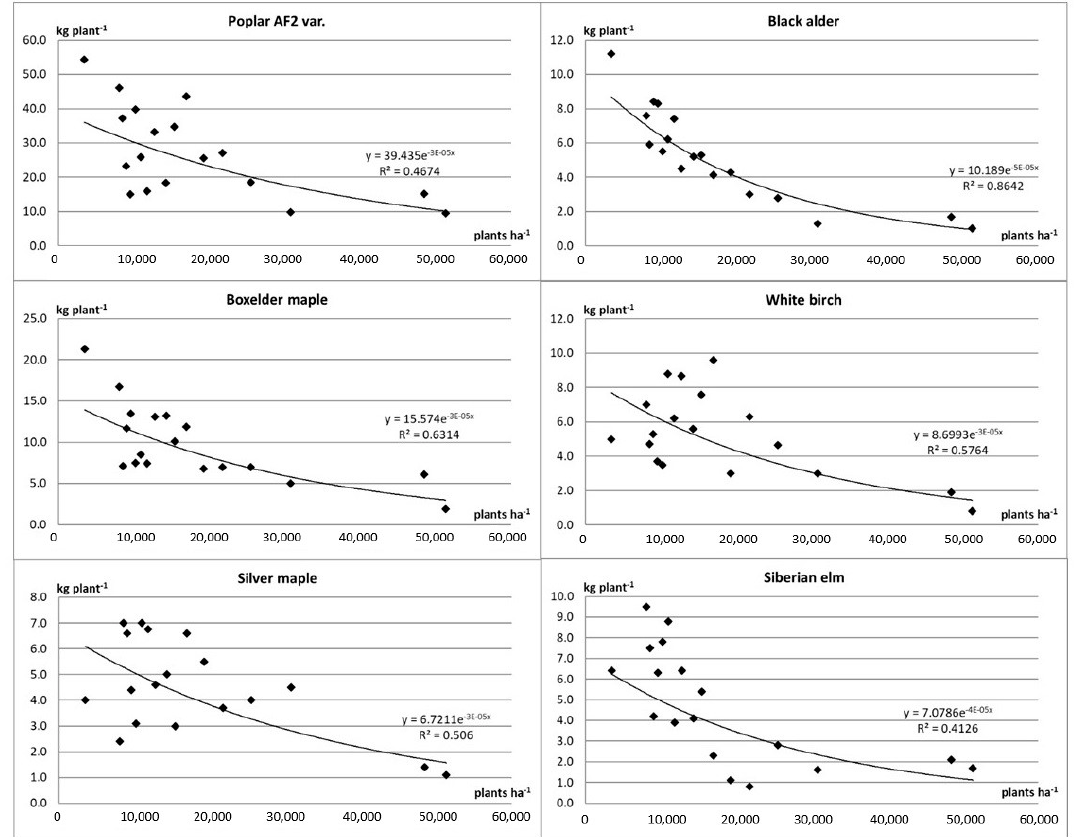
Figure 2. Relationship between green mass of plants (kg plant − 1 ) and planting density (plants ha − 1 ). Table 2. Median values of tested plants and their biometric features.